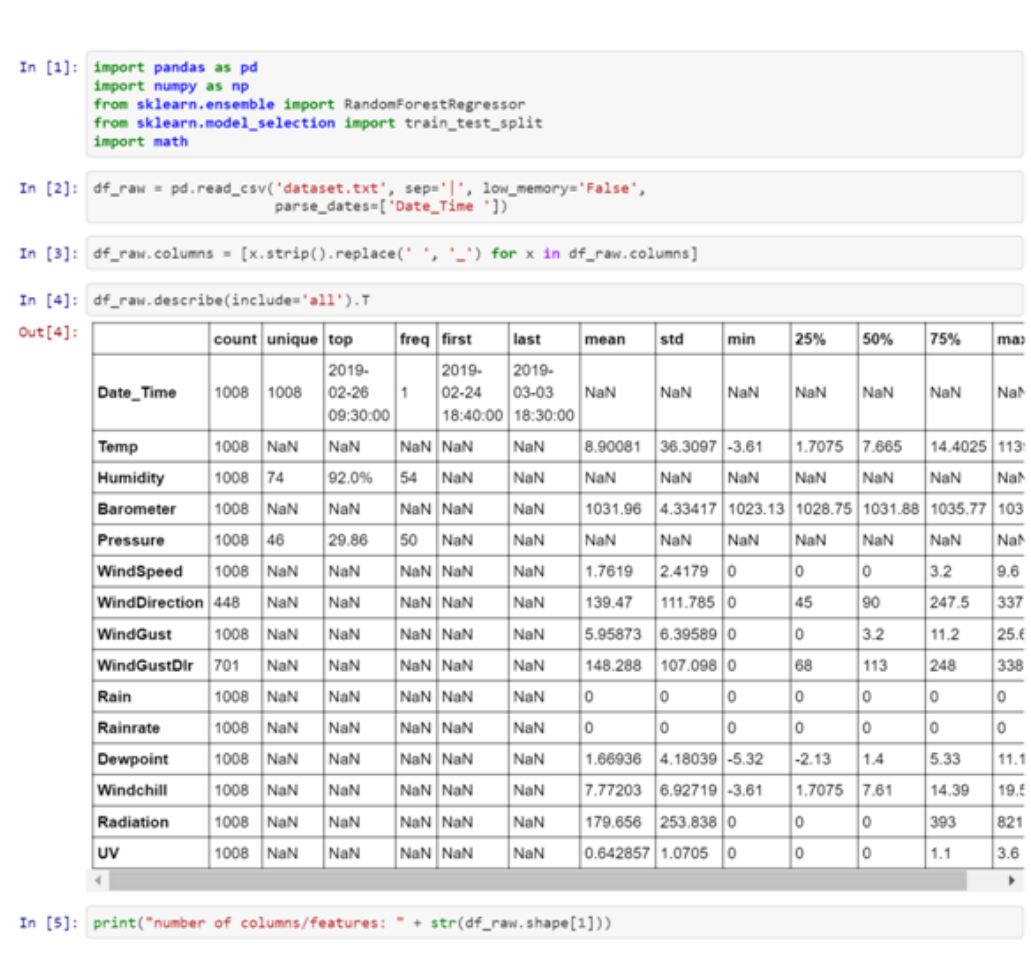
Figure A1. Summarized algorithm report - Excerpt 1.